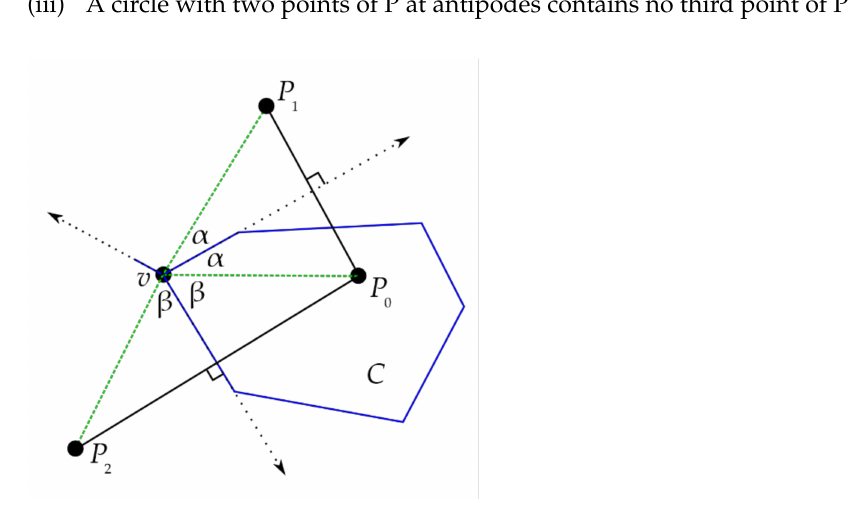
Figure 21. In the proof below, C is a Voronoi cell, v is one of its vertices, and P 0 , P 1 , and P 2 are “seeds” of the Voronoi diagram. P 0 P 1 , P 0 P 2 , and P 1 P 2 are edges in the Delaunay triangulation, although for clarity P 1 P 2 has been omitted from the